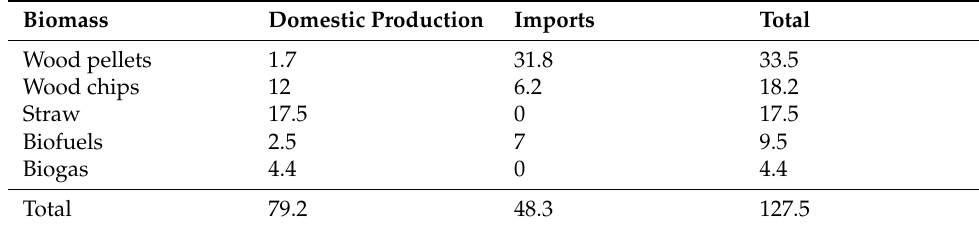
Table 1. Biomass consumption (PJ) in 2012